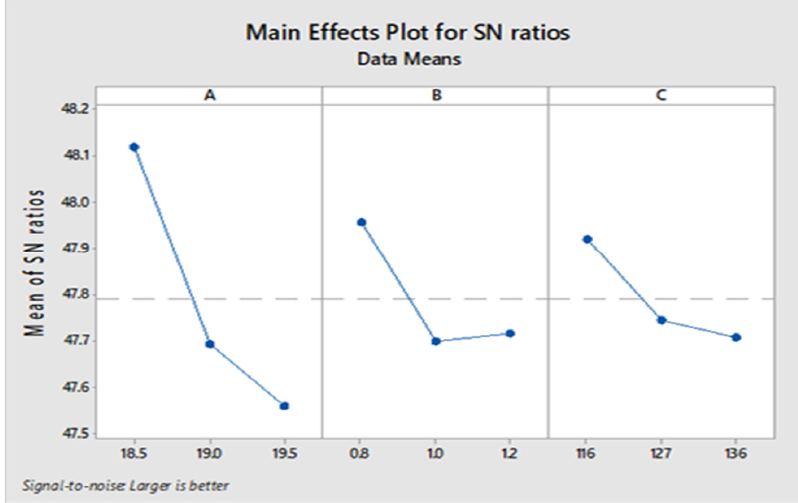
Fig. 9. Effect of a plot for S/N ratios for microhardness